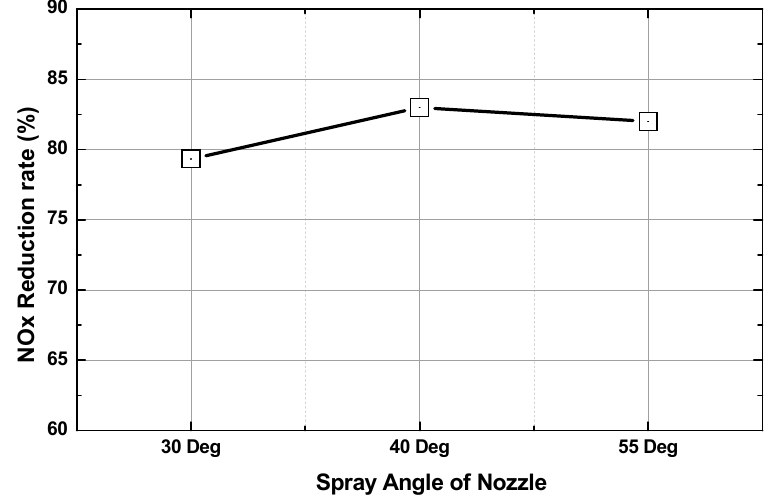
J. Mar. Sci. Eng. 2019 , 7 , x FOR PEER REVIEW